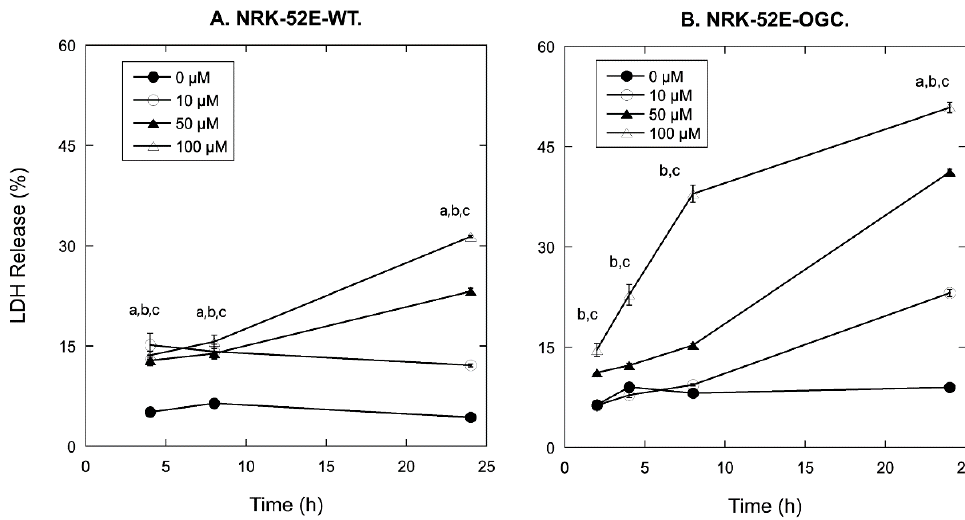
Figure 1. Time and concentration dependence of CDDP-induced LDH release. Confluent, wild-type NRK-52E (NRK-52E-WT) ( A ) and confluent, NRK-52E cells overexpressing the OGC carrier (NRK- 52E-OGC) ( B ) were incubated in 24-well cell culture plates for up to 24 h with 0, 10, 50, or 100 µM CDDP. LDH activity was measured in both culture medium and total cells. Values are means ± SEM of percent LDH release for 4 individual incubations for controls (0 µM) and 3 individual incubations for cells incubated with 10, 50, or 100 µM CDDP. a,b,c = Significantly different ( p < 0.05) from 0-µM control for 10, 50, and 100 µM CDDP, respectively, at the same time point.